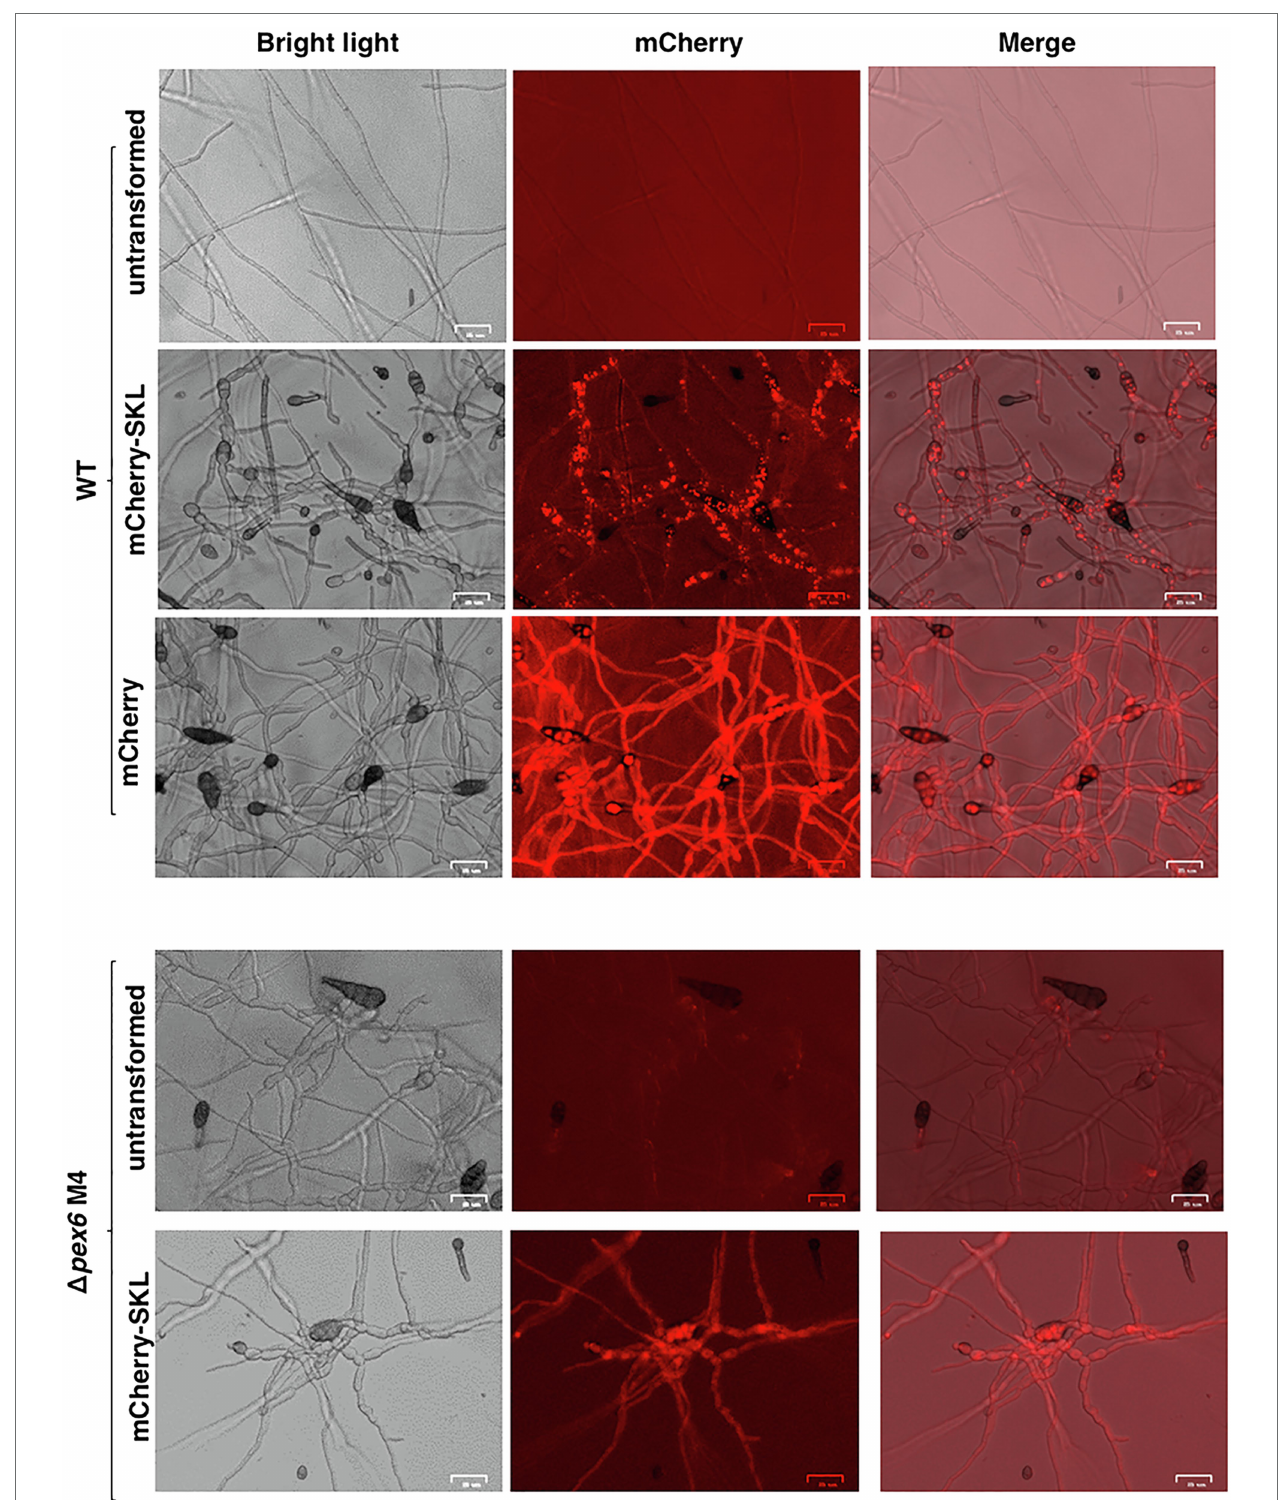
FIGURE 1 | Localization of peroxisomes in A. alternata . Fungal strains expressing a mCherry fluorescent protein tagging with or without a conserved tripeptides serine-lysing-leucine (SKL) at the carboxyl terminus. The wild-type strain (WT) expressing mCherry-SKL displays distinct red fluorescent spots. WT expressing mCherry without SKL displays uniform red fluorescence. Fungal strain ( Δ pex6 ) impaired for Pex6 expressing mCherry-SKL displays less distinct fluorescent spots compared to WT expressing the same construct. Bar = 25 μ